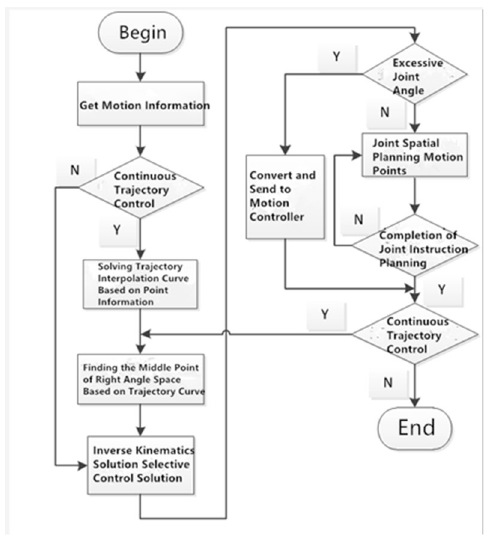
Figure 2. Trajectory planning process